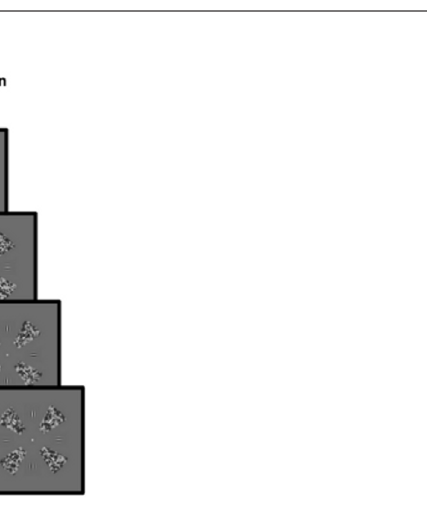
Fig. 1. A schematic of the stimulus used in the present study. The moving Gabor stimuli undergoing rotational local motion was presented to the left eye while a dynamic Mondrian mask was presented to the right eye. When viewed binocularly perception was of a Gabor stimulus with half of its elements masked by the Mondrian